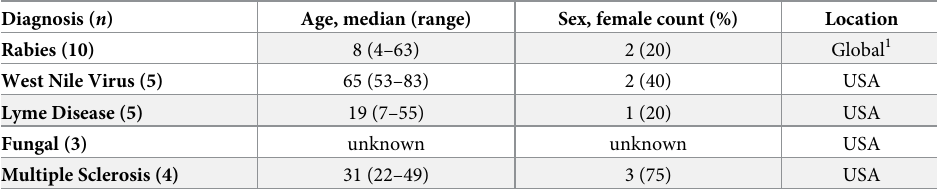
Table 1. Patient